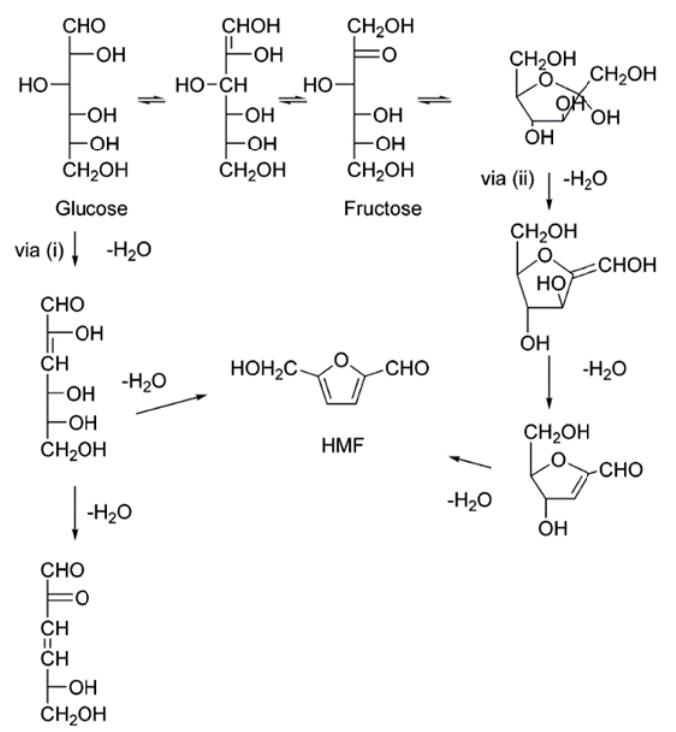
Figure 4. Pathways for the dehydration of hexoses to HMF.